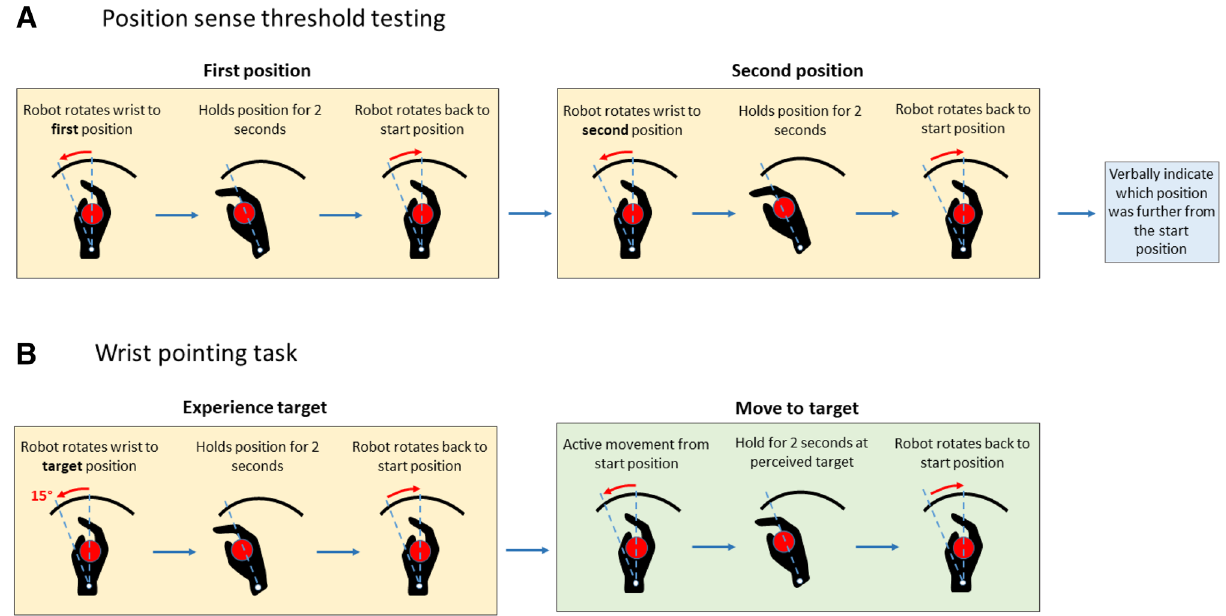
Figure 6. Proprioceptive function testing and evaluation of motor performance in the untrained motor task. ( A) Schema of the procedure for position sense acuity evaluation. Shown is the testing of the right wrist. For testing, vision was occluded. No performance feedback was given between successive trials. ( B) Schema of wrist- pointing task procedure to evaluate movement accuracy. Vision was occluded. For both wrist joints, participants actively flexed the wrist toward the perceived target position. No performance feedback was given between successive trials to avoid learning and solely test motor altered to either 10°, 15° or 20° of wrist flexion (where angular displacement is expressed relative to the neutral joint position). After a participant completed at least one successful trial in each of the three wrist flexion posi- tions the task difficulty was automatically increased by altering the following virtual mechanical properties: (1) increasing the virtual mass of the ball and increasing the gain of the velocity of the virtual ball, and (2) decreasing the friction coefficients on the virtual table. Participants used a movement range of 10° wrist extension to 40° wrist flexion to complete the training trials (see Fig. 1D). To prevent fatigue, the training session was limited to a maximum of 90 training trials or 45 min. At optimal performance (every trial was successful) a participant would have completed 30 levels of difficulty. Participants were allowed a 2-min break after every 30 trials. Procedure: assessment and measurements. Evaluation of task-specific motor learning. In order to evaluate the effects of motor learning during the visuomotor task, all participants’ wrist angular time-series data were recorded using the signals of the position encoders of the robot. Instantaneous lateral deviation (LD) of the wrist from the neutral position was computed and cumulative spatial error for each trial was calculated using the equation below 6 : n (1) CSE trial = (cid:31) where n is the last sample of each trial. Movement time was defined as the time of complete each trial. Cumulative spatial error (CSE) and movement time (MT) were derived for each trial. Changes in CSE and MT represented the measures to indicate performance changes during the training of the visuomotor task (i.e. task-specific motor learning; see Fig. 1B,C). Evaluation of proprioceptive acuity. Proprioceptive acuity was evaluated in a wrist position sense discrimina- tion task using the wrist robot. A psychophysical forced-choice paradigm was employed to evaluate wrist pro- prioceptive acuity. Participants wore opaque goggles and headphones playing white noise to block visual and auditory cues. In each trial, participants had to discriminate between two passively presented stimulus positions (a standard stimulus of 15° flexion and a comparison stimulus always greater than 15°, see Fig. 6A). The order of the standard and comparison stimuli presentation was randomized. The robot moved the wrist at a velocity of 6°/s from start (neutral position) to each stimulus position, held for 2 s, and then moved back to start. After both positions were presented, participants verbally indicated which position (first or second) was farther from the start position. The subsequent stimulus pair was then determined based on the verbal response by an adap- tive psychophysical psi-marginal algorithm 37 . The complete evaluation consisted of 30 trials. Participants were allowed a 2 min break after 15 trials to avoid testing related fatigue. Participants’ verbal responses and the corre- sponding stimulus difference size (angular difference between comparison and stimulus positions) were recorded